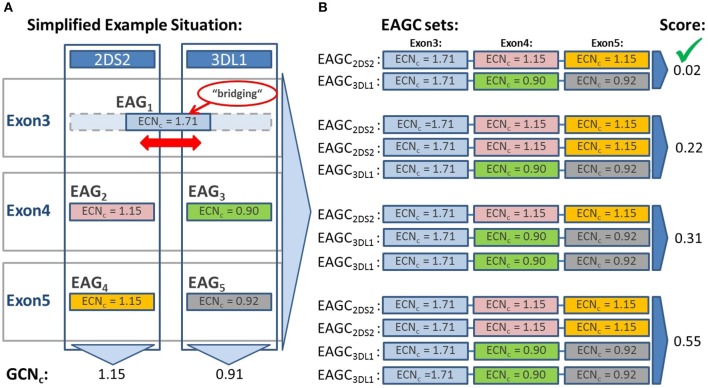
Evaluation of result sets based on the calculation of the result set score S. The result set score S is calculated to evaluate potential results and identify the most likely one. Each result set is composed of different combinations of detected exon sequences (EAGs). This example depicts three exons of two genes sharing in exon 3 the same sequence (bridging EAG). (A) EAGs identified in each exon with associated Exon Sequence Copy Numbers (ECNcs). The ECNcs are derived from the number of detected reads by applying several normalization and correction factors. The gene copy number (GCNc) is estimated for each gene by first building the sum of the ECNcs of all EAGs in each exon and then averaging the sums over the exons (ignoring exons with bridging EAGs). (B) Based on the detected EAGs neXtype calculates result sets (EAGC sets) consisting of EAG combinations (EAGCs) which correspond to named alleles. In this example EAGC sets with one or two copies per gene are evaluated because the calculated gene copy number (GCNc) is close to 1 for both genes. The EAGC set with one copy of each gene yields the lowest score of 0.02 and is therefore selected as final result.